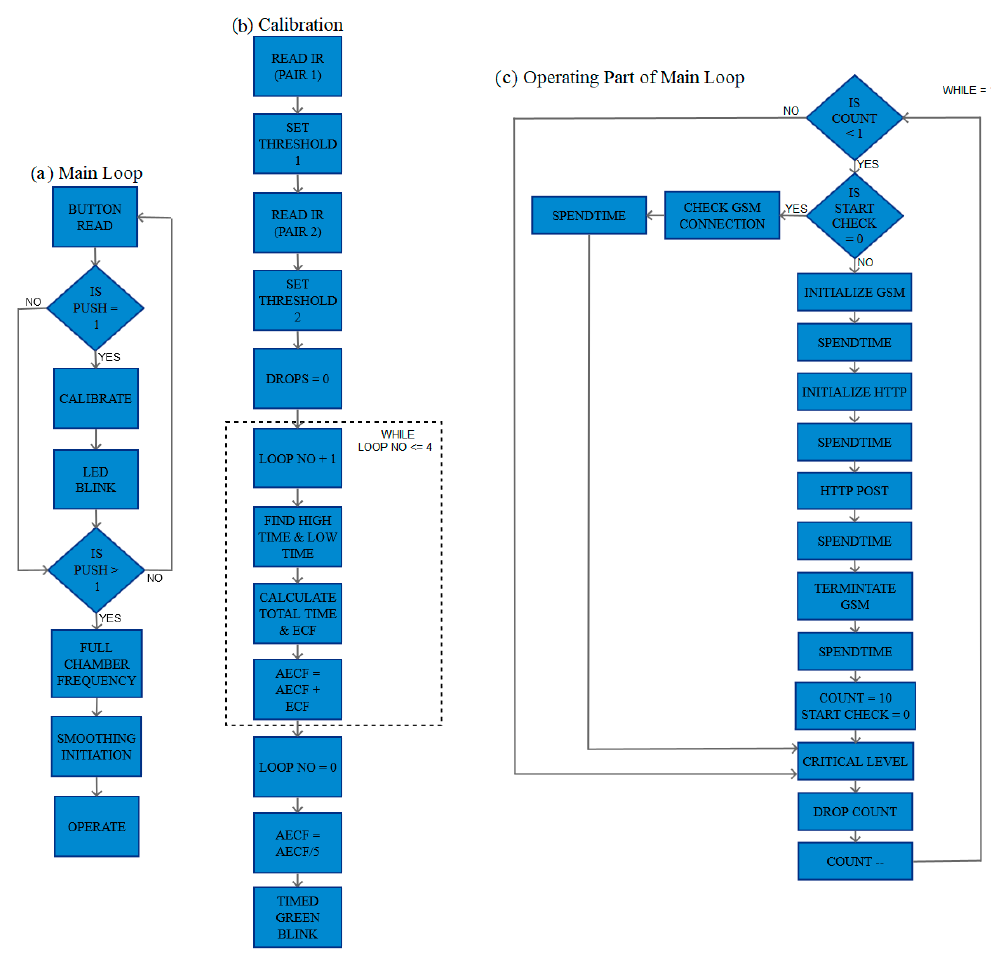
Figure 5. Block diagram of: ( a ) main loop; ( b ) calibration block; and ( c ) operate block of main loop.